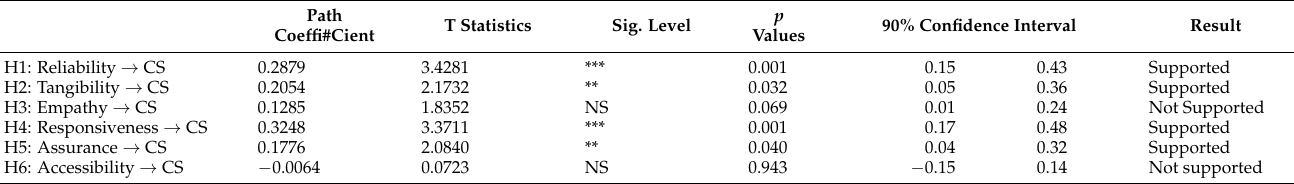
Table 4. Path coefficient and significance level by the bootstrapping